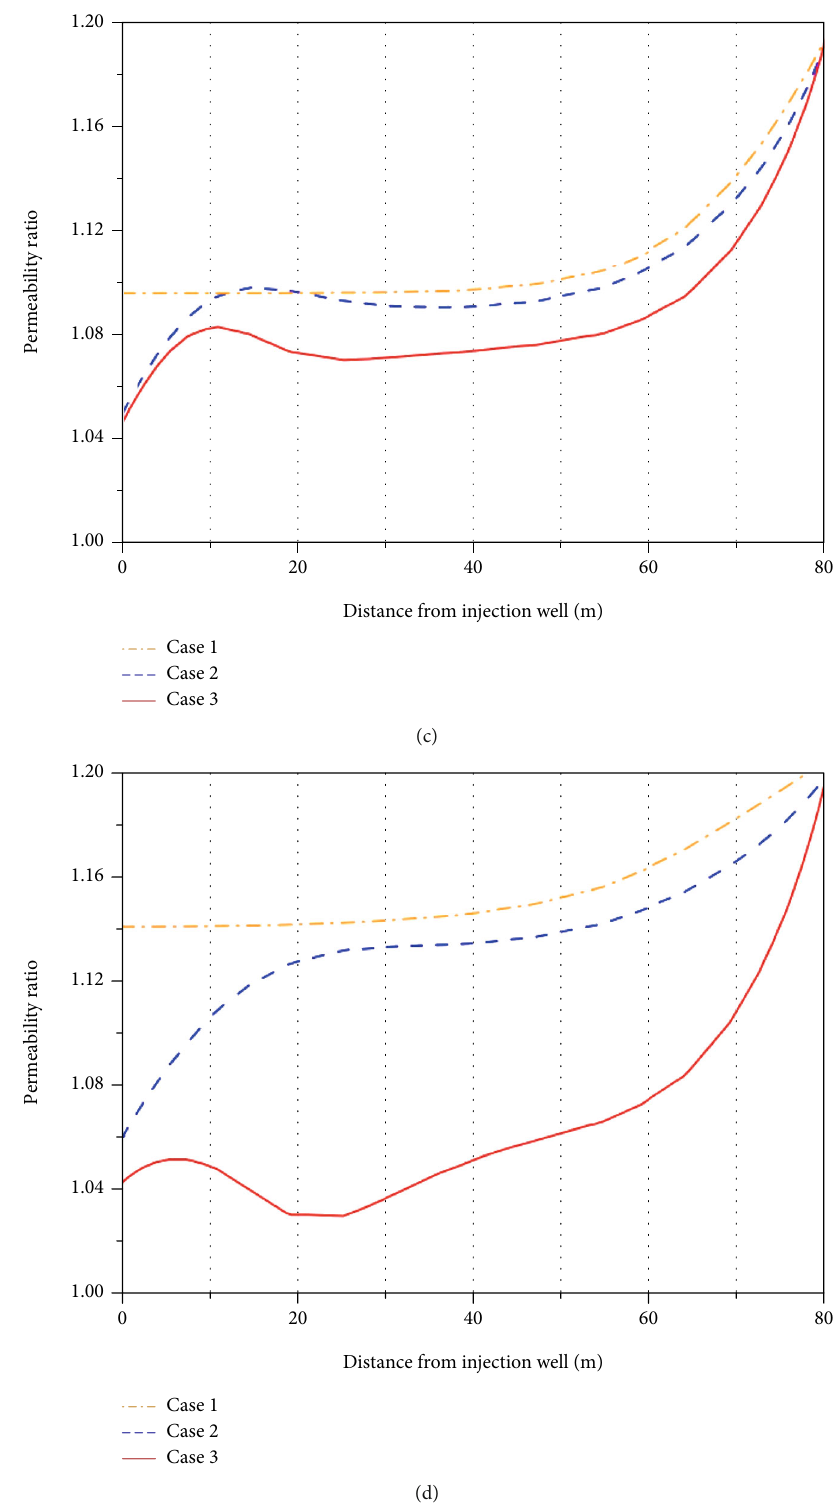
Figure 15: The spatial distribution of permeability ratio for three di ff erent cases at monitoring line after (a) one-year, (b) four-year, (c) ten- year, and (d) twenty-year